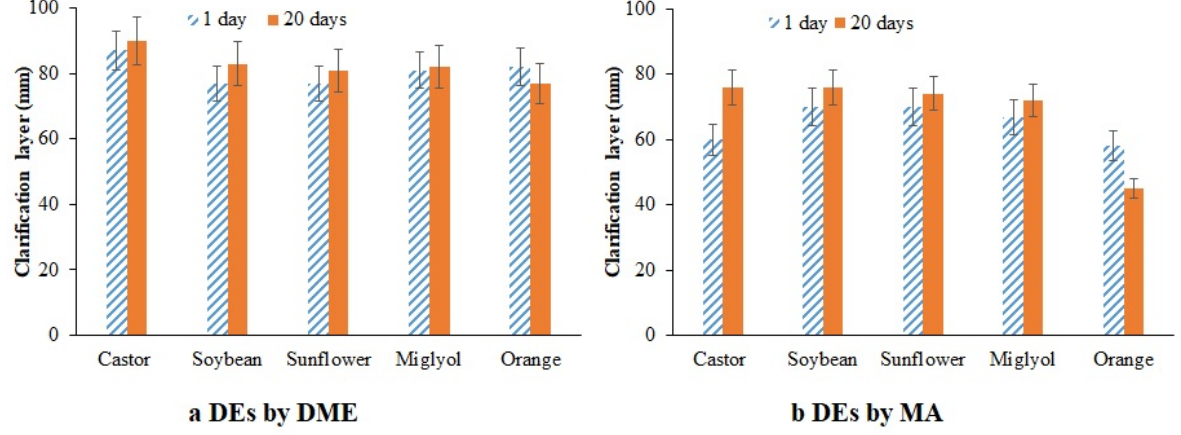
Figure 5. Clarification layer after 1 day and after 20 days of storage. ( a ) DEs prepared by DME; ( b ) DEs prepared by MA.